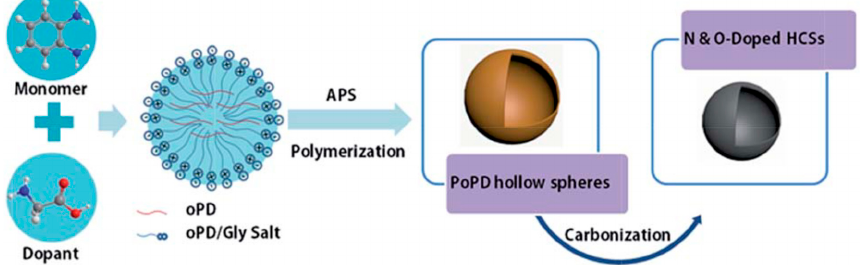
Figure 7. A schematic illustration depicting the synthesis route for N- and O-doped HCSs. Reprinted with permission from [85], copyright 2015, RSC Publishing.